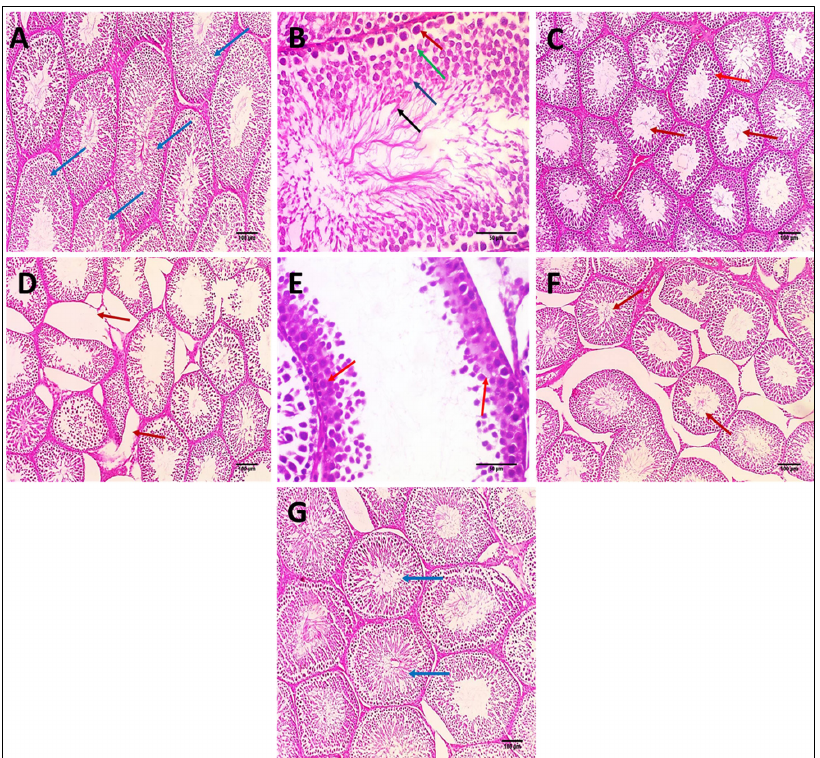
Figure 6. Effects of Bilobetin treatment on histopathological examination of testicular tissue. ( A ) Section of testis of normal control rat showed seminiferous tubules (blue arrows) lined by layers of spermatogenic cells and filled with spermatozoa. (H&E ×100). ( B ) Higher magnification of normal testis showed seminiferous tubule showing complete layers of spermatogenesis consisting of layers of spermatogonia (red arrow), spermatocytes (green arrow), spermatids (blue arrow), and sperma- tozoa (black arrows) (H&E × 400) and showed the Johnson score: [10] complete spermatogenesis with mature sperms. ( C ) Section of testis of Bilobetin 12 treated group showed seminiferous tubules (red arrows) lined by layers of spermatogenic cells and filled with spermatozoa (H&E ×100) and showed a Johnson score: [10] complete spermatogenesis with mature sperms. ( D ) Section of testis